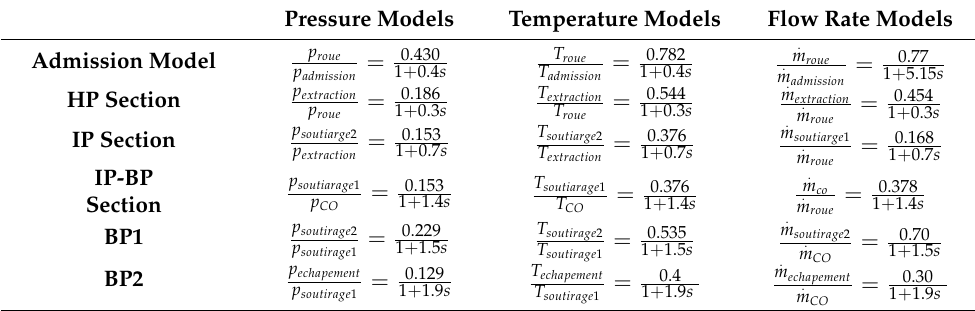
Table 3. Steam turbine sections models based on turbine design